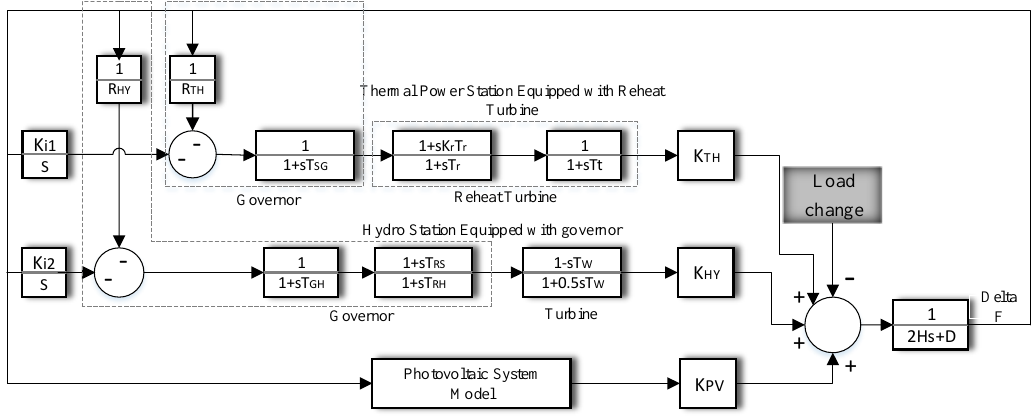
Figure 2. A linear block diagram of the suggested scheme.